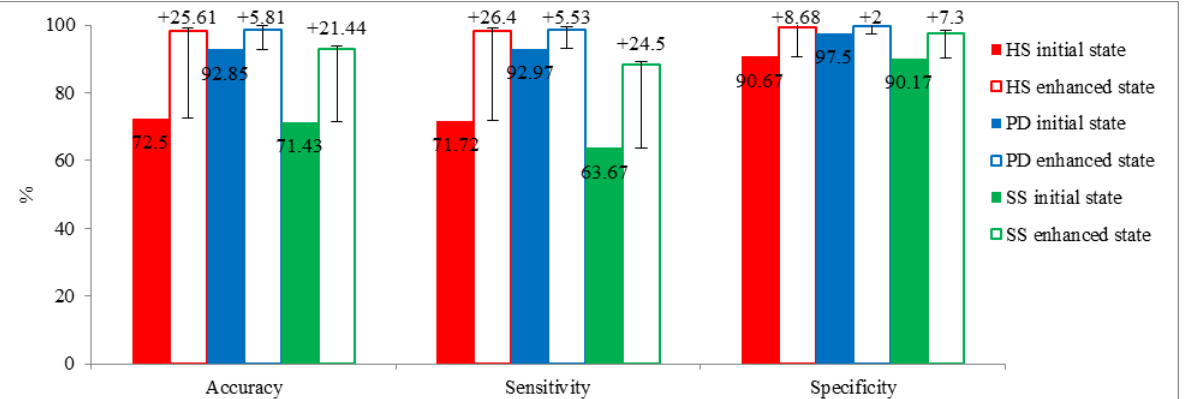
Figure 2. Comparison of performance matrices between initial and enhanced states in the local da- taset. Sensitivity and specificity values are normalized to 0 – 100 to provide comparable results with